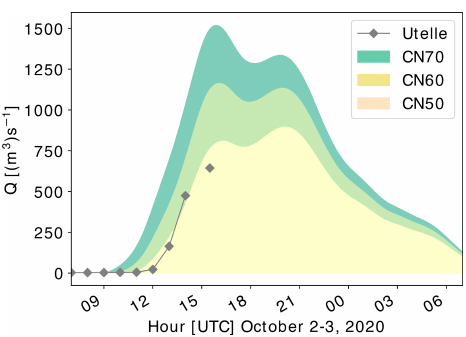
Figure B5. Runoff modeling for three different basin saturation scenarios: CN70 (moderate saturation), CN60, and CN50 (rather dry condi- tions). Available runoff measurements from the stream gauge at Utelle are presented in gray diamonds. The comparison between the stream gauge measurements and runoff modeling indicates rather dry basin conditions (CN50 scenario). However, there is an uncertainty in the runoff modeling related to the estimated flow velocities on the slope (0.2ms − 1 ) and in the river (5.0ms − 1 ). Moreover, the estimated runoff values are too low compared to the damage that occurred in the Vésubie catchment.